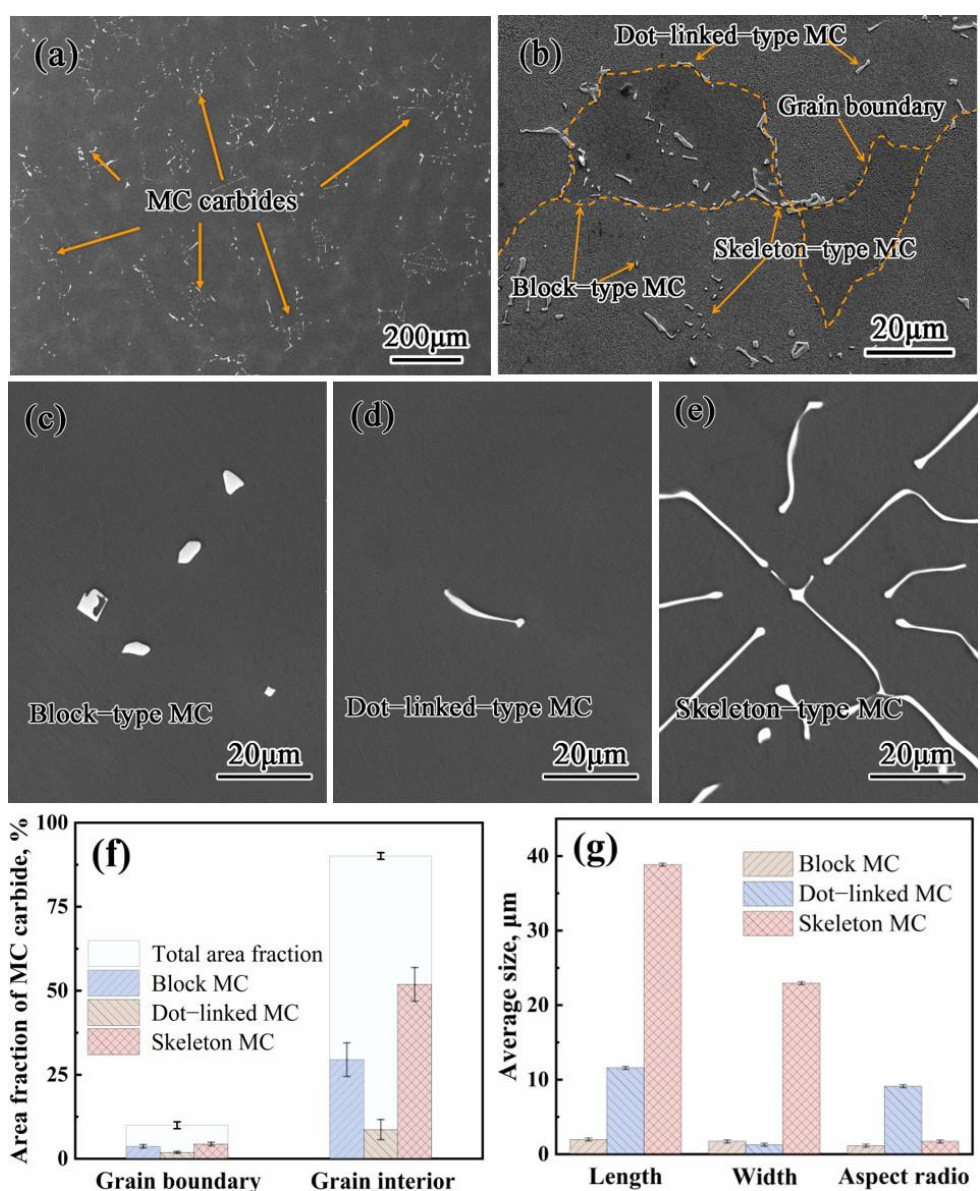
Figure 2. Distribution, morphology, and evaluation of MC carbides. ( a ) It shows the overall distribution and morphology of MC carbides. ( b ) MC carbides distribute inside the grains and on the grain boundaries. ( c ) It shows the morphology of block-type MC carbides. ( d ) It shows the morphology of dot-linked-type MC carbides. ( e ) It shows the morphology of skeleton-type MC carbides. ( f ) The area fraction of MC carbides is significantly different. ( g ) Each type of MC carbide has a remarkable variation in average size.